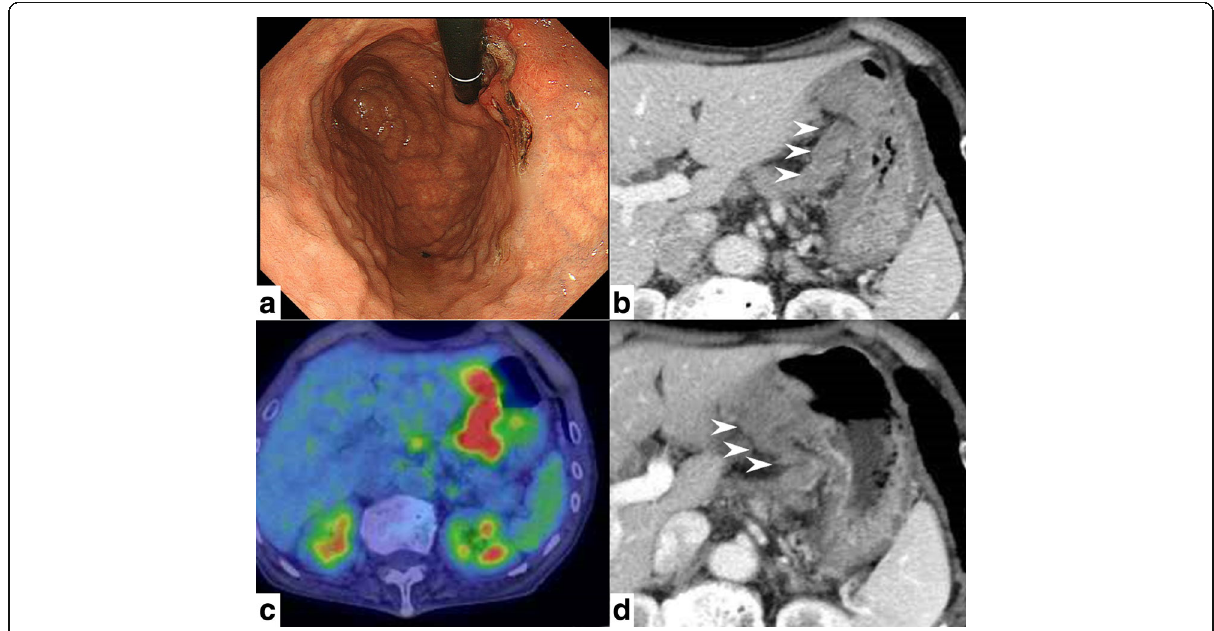
Fig. 1 a Endoscopic findings. A Borrmann type III tumor was found in the cardiac end of the stomach and irregular wall thickening was identified in the lesser curvature. b Abdominal contrast-enhanced computed tomography (CT) findings. Abdominal contrast-enhanced CT indicated that the lesser curvature stomach wall was modestly enhanced with suspicious bulky lymph nodes in the lesser curvature (white arrowhead). c Positron emission tomography (PET) findings. PET revealed an accumulation of fludeoxyglucose (18F) in the stomach wall and bulky lymph nodes were detected by computed tomography (CT). d Abdominal contrast-enhanced computed tomography (CT) findings after preoperative chemotherapy. Abdominal contrast-enhanced CT demonstrated that the size of tumor and bulky lymph nodes had not changed (white